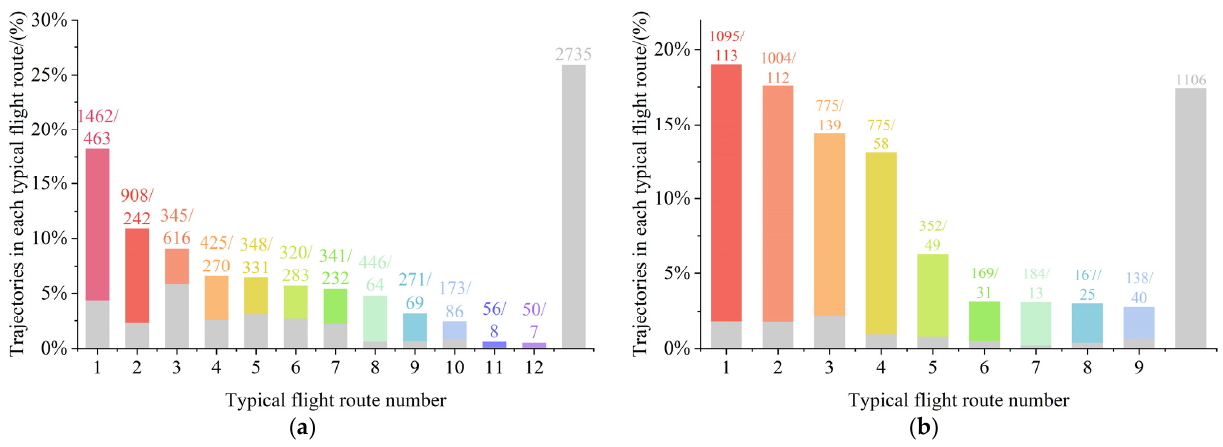
Figure 9. Percentage of flight trajectories on typical flight routes. ( a ) ZGGG; ( b ) ZHHH. To verify the clustering results of the OPTICS algorithm, K-Means and DBSCAN al-